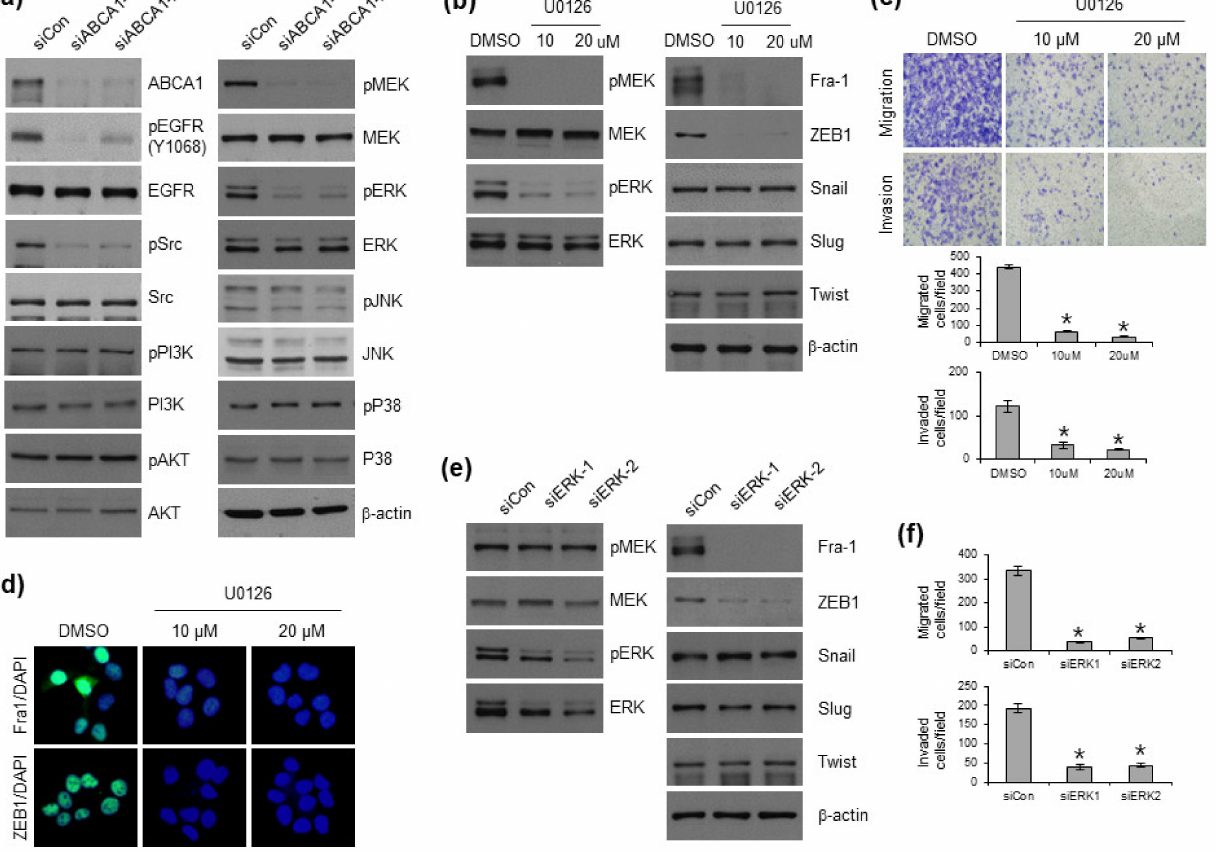
Figure 4. Knockdown of ABCA1 using siRNAs suppresses EMT by inhibiting the ERK pathway. ( a ) Protein expressions of the indicated signaling pathways in siRNA-mediated ABCA1-knocked-down BCPAP cells were measured using Western blotting. Expression levels of the indicated proteins in BCPAP cells were analyzed after treatment with U0126 ( b ) or siRNA against ERK ( e ) via Western blotting. ( c ) Migration (upper) and invasion (lower) of U0126-treated BCPAP cells were analyzed and quantified. * p < 0.05, compared to DMSO-treated cells (Student’s t -test). ( d ) Effects of U0126 on Fra-1 and ZEB1 expressions were examined via immunofluorescence staining. ( f ) Graphs show the migration (upper) and invasion (lower) abilities of siRNA-mediated ERK-knocked-down BCPAP